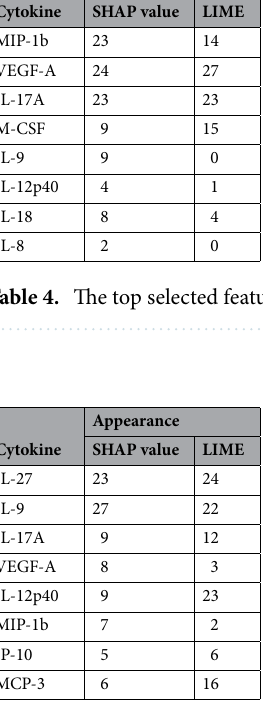
Table 5. The top selected feature in the case of non-Severity for both